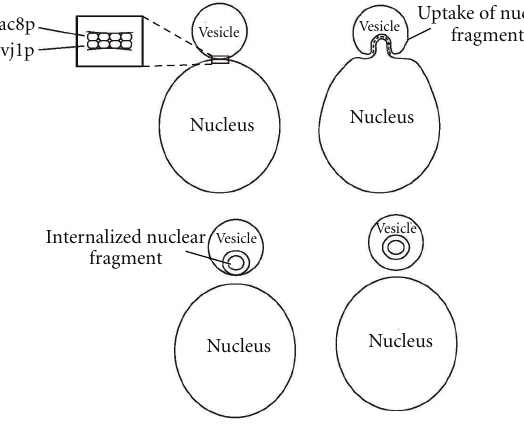
Figure 3: Piecemeal Microautophagy. In yeast, the vacuole and nuclear membrane form a tight junction between proteins Vac8p (Vacuole) and Nvj1p (Nuclear) (a). As the vacuole invaginates, the nuclear membrane is pulled inward due to the interaction between Vac8p and Nvj1p (b). This continues until an autophagic-like body forms within the vacuole and pinches o ff from the membrane (c) and is released into the vacuole where it is later degraded (d). Vac8p: Vacuolar 8 protein; Nvj1p: nucleus vacuole junction 1